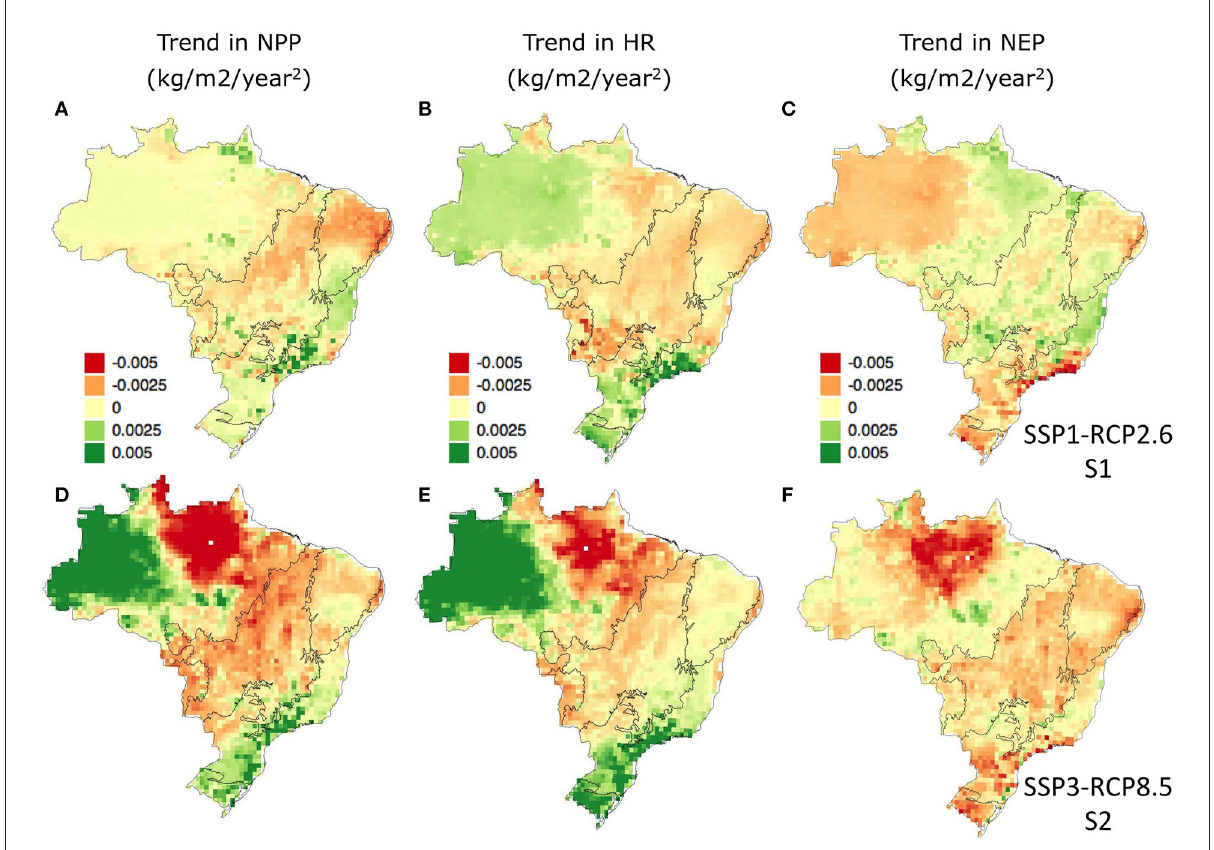
FIGURE9 Trend coefficient in the carbon fluxes (kgC/m 2 /year 2 ) for net primary productivity in (A) SSP1-RCP2.6 and (D) SSP3-RCP8.5, heterotrophic respiration in (B) SSP1-RCP2.6 and (E) SSP3-RCP8.5, and net ecosystem productivity in (C) SSP1-RCP2.6 and (F)